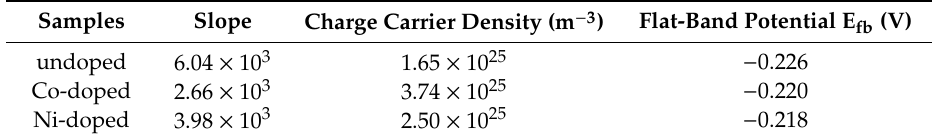
Table 2. Charge carrier density and flat potential of the α -Fe 2 O 3 samples determined by Mott–Schottky plots.